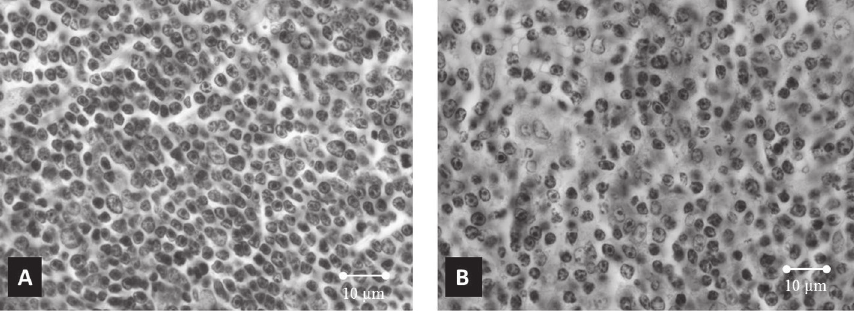
Figure 1 - digital micrographs (1,000x magnification) of thymus cortex (A) and medulla (B)